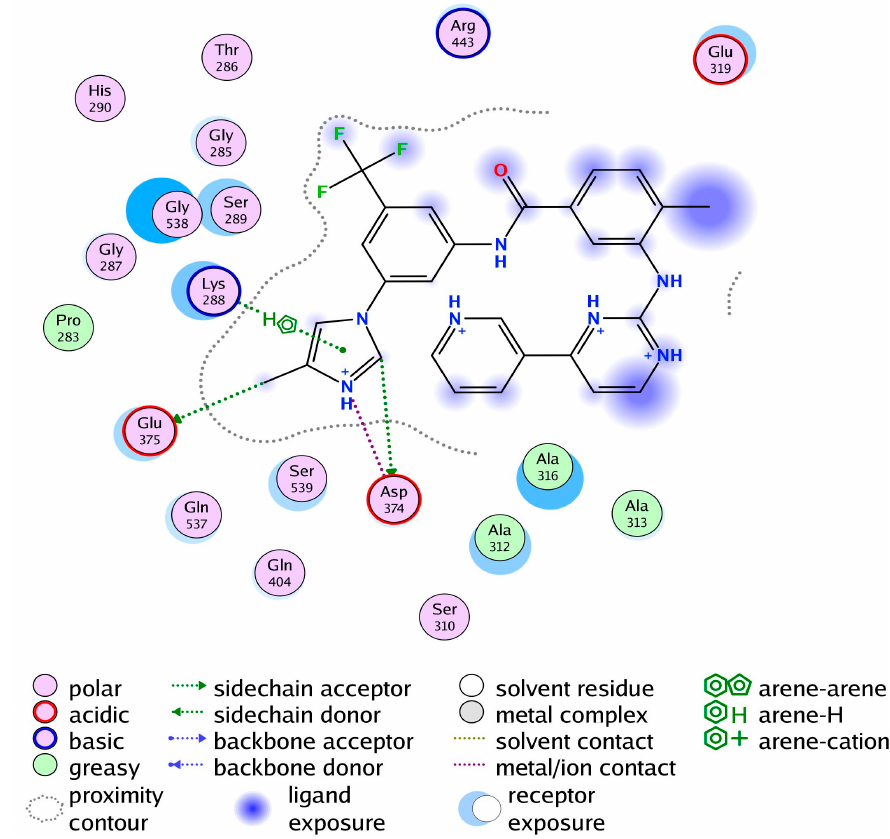
Figure 4. Binding interaction network of the control with SARS-CoV-3 helicase enzyme.